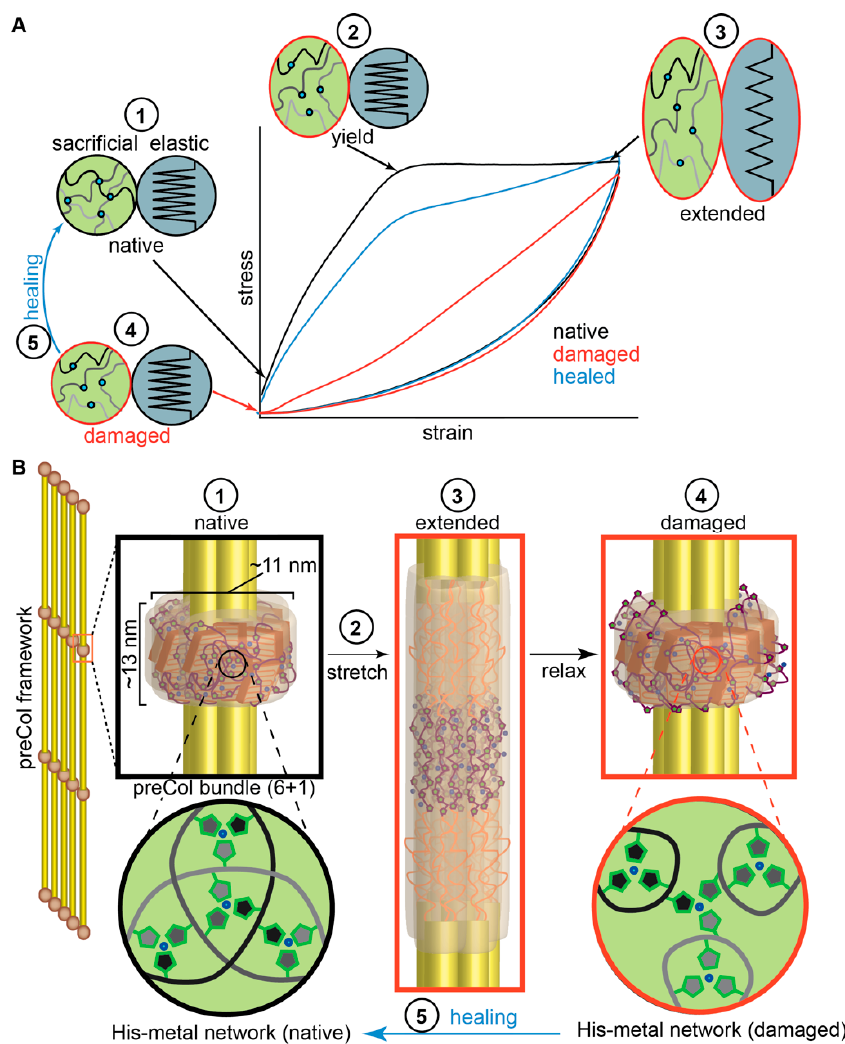
Figure 3. Model of byssal thread damage and self-healing. ( A ) Schematically, the byssus healing mechanism can be illustrated as a combination of a sacrificial bonding network and a source of elastic hidden length. The sacrificial network (1) begins to rupture at the yield point (2), transferring load to the elastic hidden length causing it to extend (3). When load is removed, the elastic component drives recovery of the initial length, but the sacrificial network is damaged (4). However, over time, the sacrificial network recovers toward its native state (5). ( B ) Within the hierarchical semicrystalline structure of the distal byssal thread core, the sacrificial bond network is comprised of an optimal network of intermolecular His–metal bonds that surrounds cross β -sheet structure in the flanking domains, which serve as a source reversible hidden length. Reprinted from [4], Copyright 2016, with permission from Elsevier.